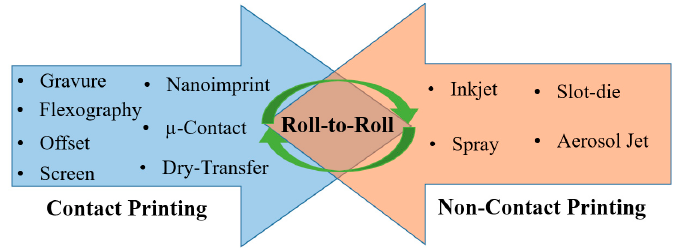
Figure 4. Summary of representative contact- and non-contact-based printing technologies.